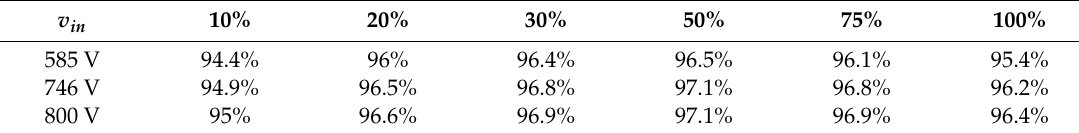
Table 3. Power-One ULTRA-750-TL-OUTD-4-US e ffi ciency data.